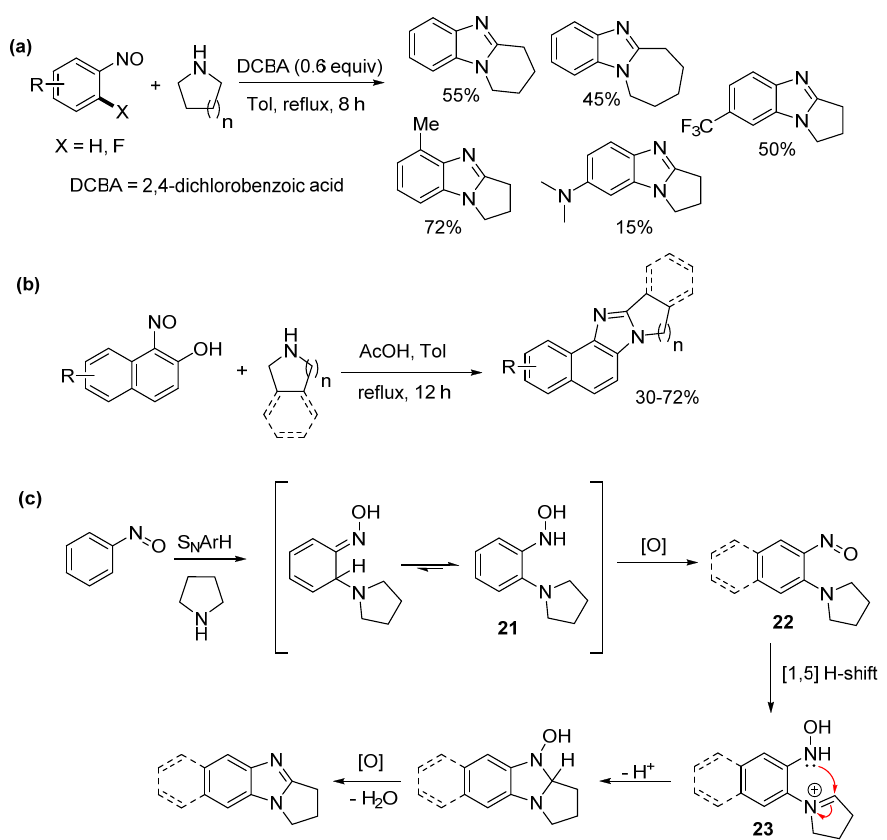
Scheme 16. Sequential aminations of nitrosoarenes to prepare ( a ) alicyclic ring-fused benzimidaz- oles, ( b ) naphthoimidazoles, and ( c ) the proposed mechanism